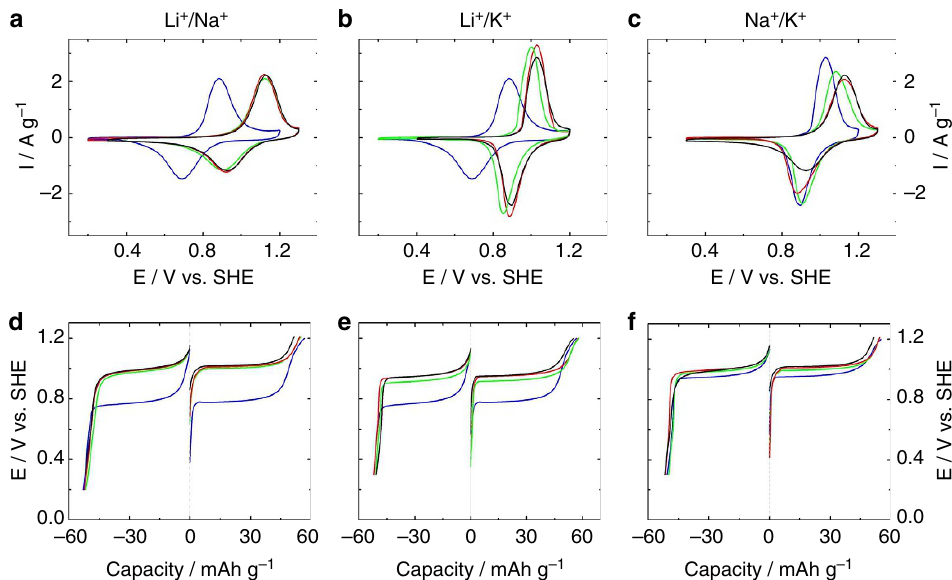
Figure 2 | Electrochemical properties of InHCF/Gr. ( a – f ) Cyclic voltammograms ( a – c ) at a scan rate of 2mVs (cid:2) 1 and galvanostatic profiles ( d – f ) measured at a rate of 1C for InHCF/Gr in various electrolytes (1C ¼ 60mAg (cid:2) 1 ). All electrode potentials are versus standard hydrogen electrode (SHE). Blue line is corresponding to 0.5M Li 2 SO 4 in a , b , d and e ) or 0.5M K 2 SO 4 in c and f Green line is corresponding to 0.25M Li 2 SO 4 /0.25M Na 2 SO 4 in a and d or 0.25M Li 2 SO 4 /0.25M K 2 SO 4 in b and e or 0.25M Na 2 SO 4 /0.25M K 2 SO 4 in c and f . Red line is corresponding to 0.1M Li 2 SO 4 /0.4M Na 2 SO 4 in a and d or 0.1M